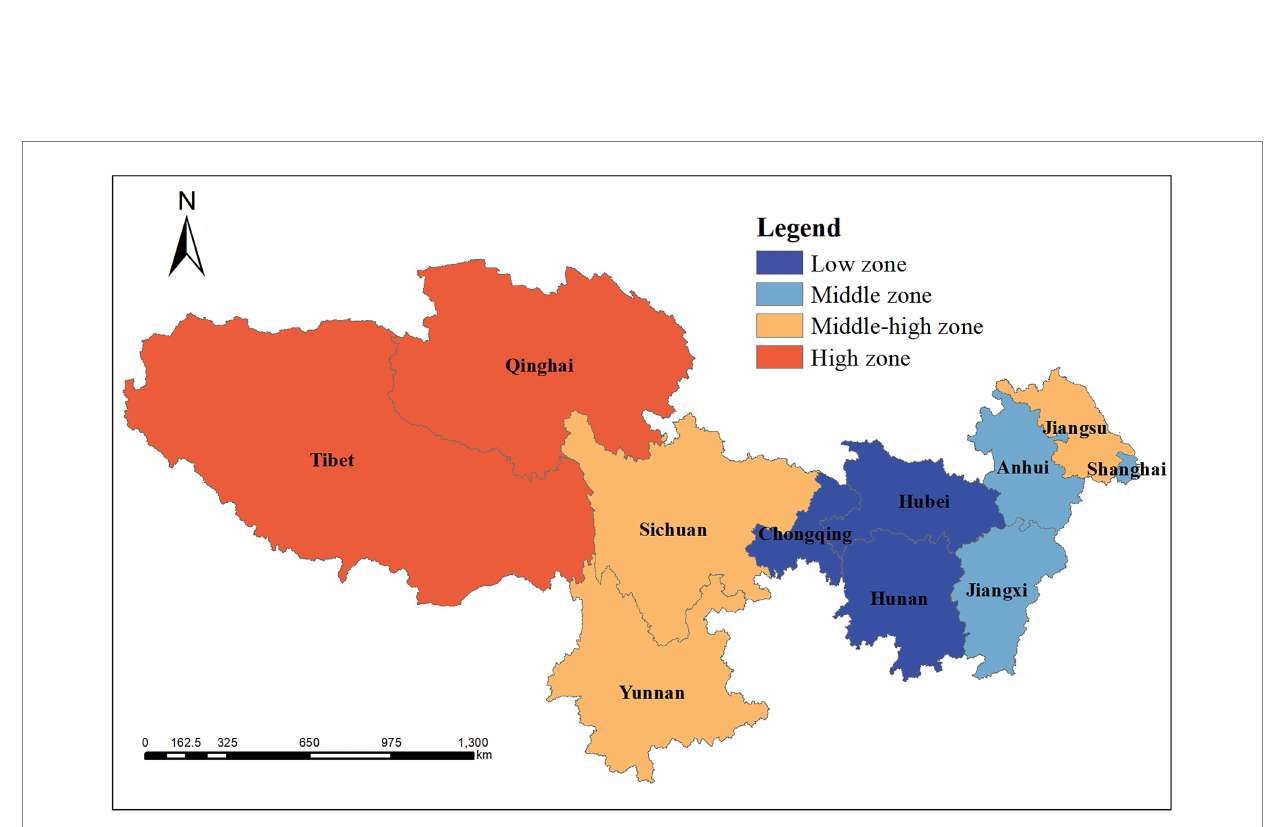
FIGURE 7 Dynamic changes of tourism economic development in the Yangtze River